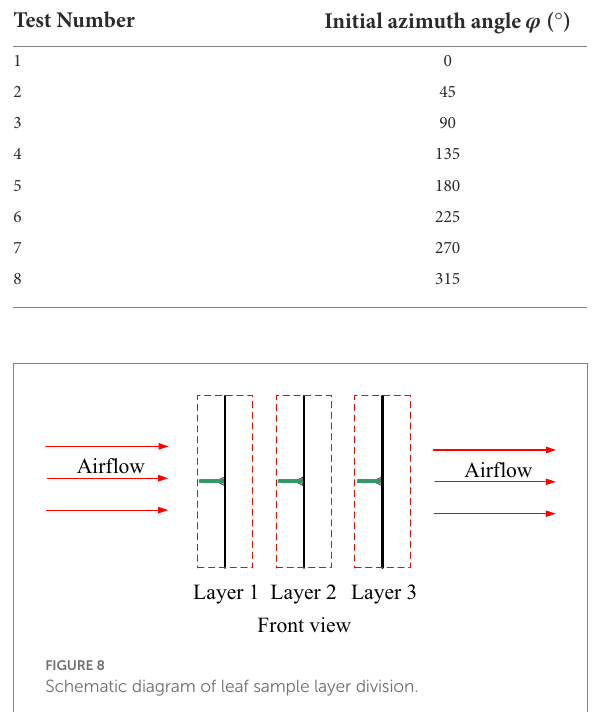
TABLE 3 Test scheme of airflow resistance characteristics of single leaf at multiple positions.